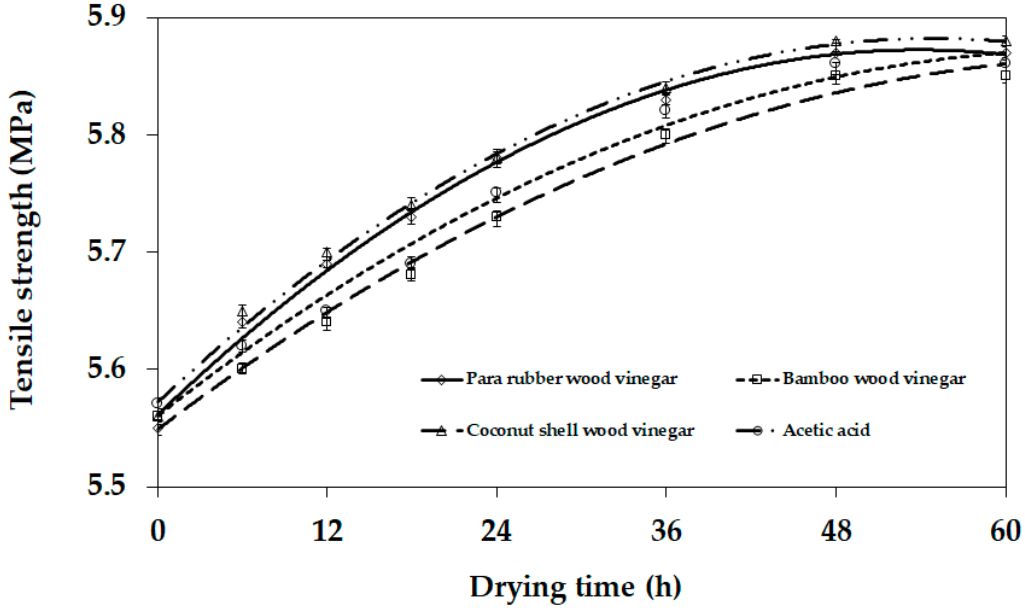
Figure 2. Tensile strength at break change during the drying process.